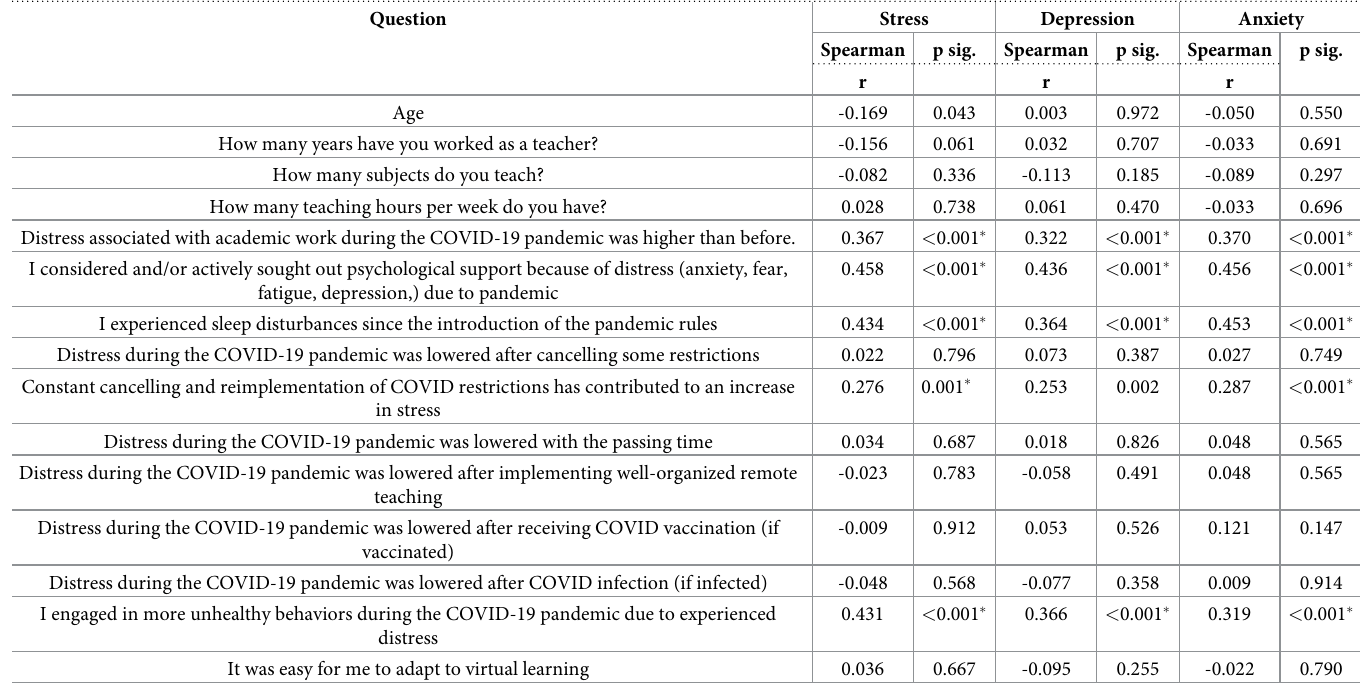
Table 4. Spearman rank order correlations between psychological distress predictors and anxiety, stress, and depression.